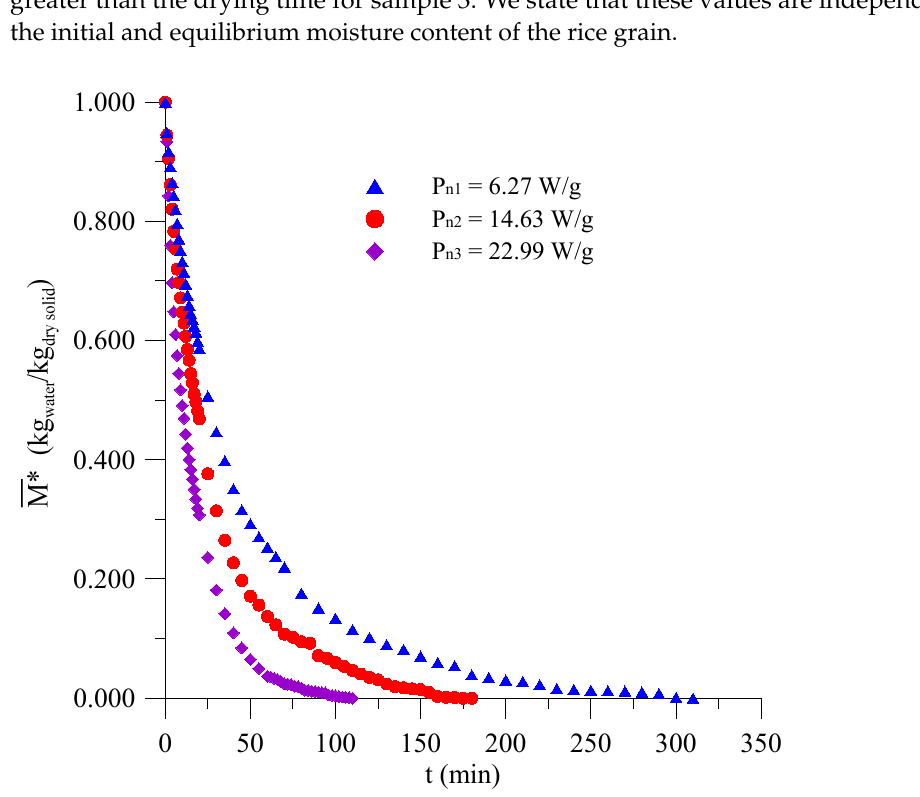
Figure 5. Average dimensionless moisture content of the paddy rice as a function of microwave drying time.